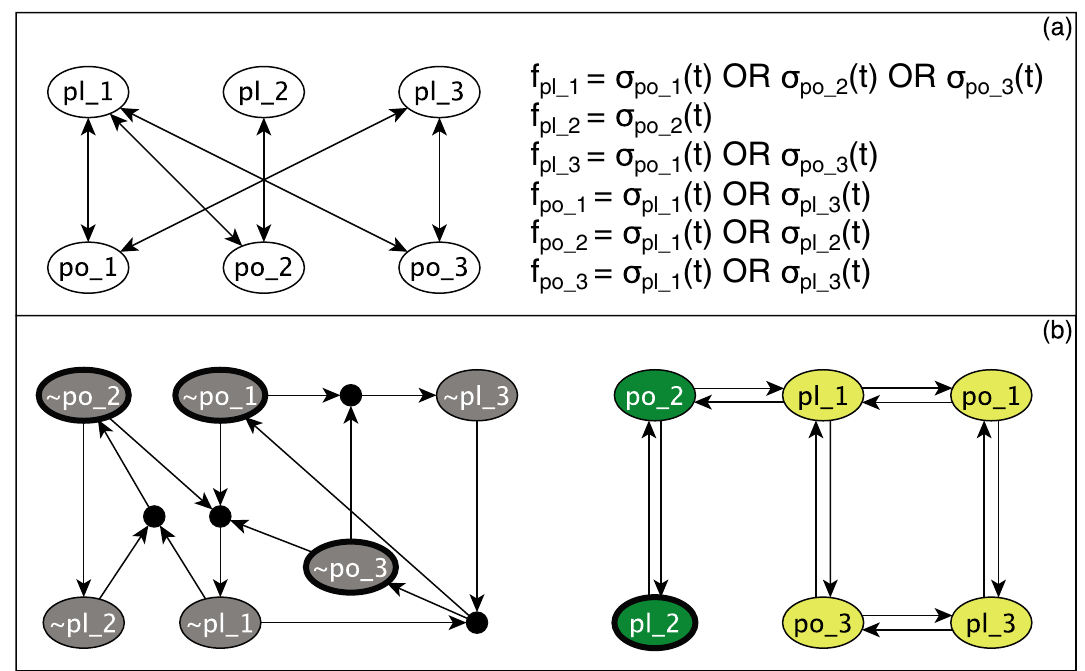
Figure 1. Illustration of Boolean modeling key concepts in the context of a plant–pollinator interaction network. ( a ) The interaction network with the Boolean threshold functions converted to disjunctive prime format. ( b ) The expanded network in which there is a black composite node for each “AND” gate and two virtual nodes representing the possible node states. The active state is denoted by the node name and the inactive state is shown using the name of the node prefixed with ∼ . The inactive stable motif highlighted with grey corresponds to the full community collapse. One of the multiple driver sets of this stable motif is indicated by solid black outlines. The whole grey stable motif is in the LDOI of this driver set. The stable motif highlighted with dark green is one of the active stable motifs driven by either virtual node pl_2 (outlined) or po_2. The virtual nodes highlighted with light green are stabilized as a result of stabilization of this stable motif, i.e., they are in the LDOI of the dark green stable motif. The LDOI of the dark green stable motif also contains the virtual nodes of the dark green stable motif, as generally true for all stable